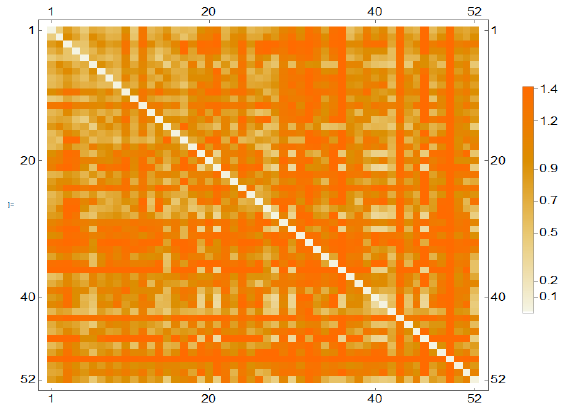
Figure 1. LTD-Distance Matrix